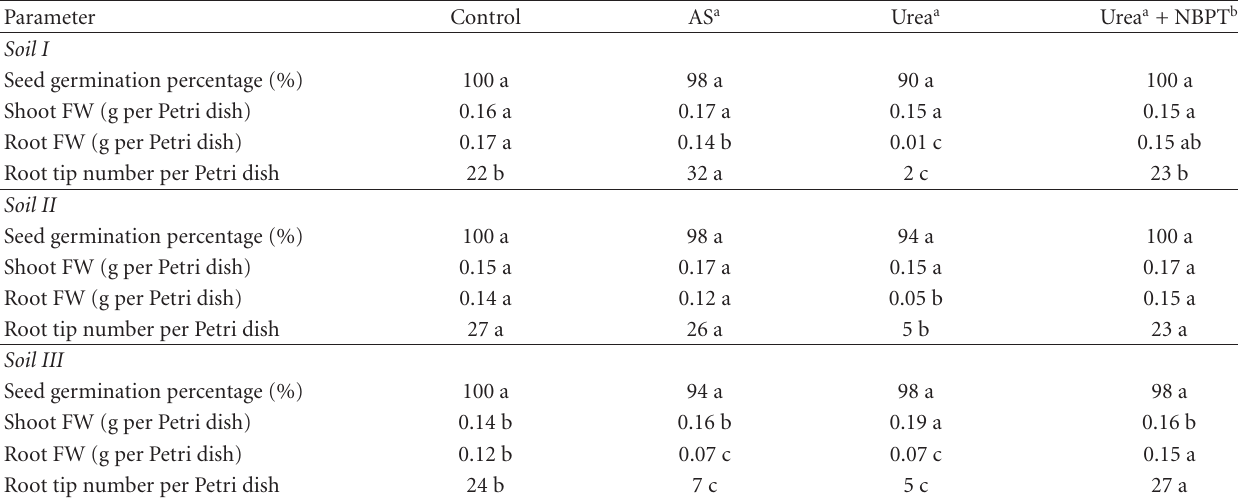
Within a row, means followed by di ff erent letters are significantly di ff erent at 0.05 probability level according to Least Significant Di ff erence (LSD) test. a The rate of ammonium sulfate and urea was 0.15gN per Petri dish. b The rate of NBPT was 1.5mg per Petri dish.